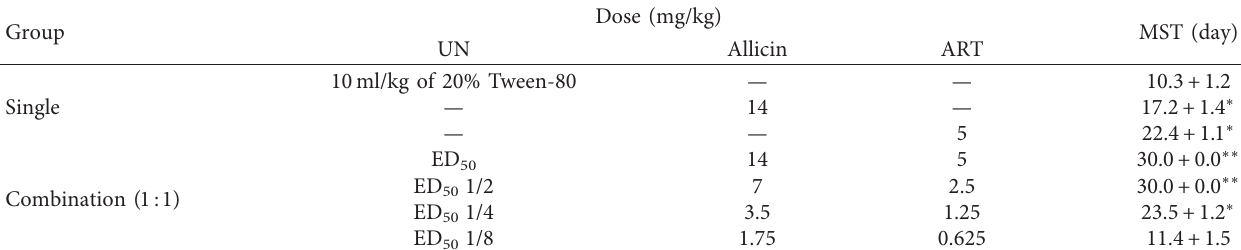
Table 5: Effect of allicin and its combination with ART on MST in PbANKA infection in mice.